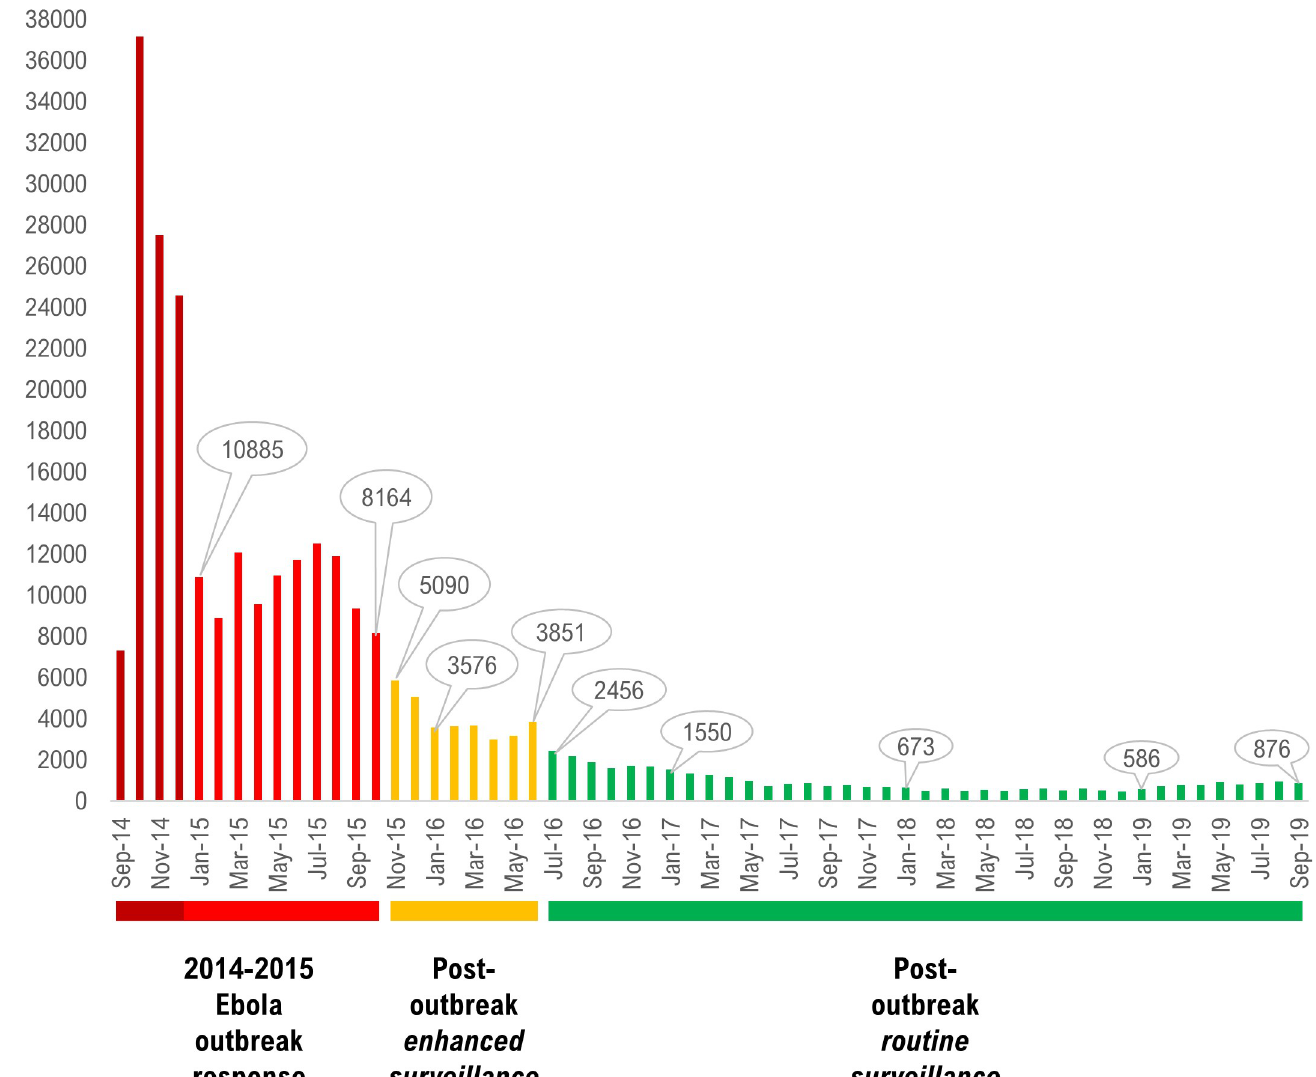
Fig 1. Distribution of the monthly unadjusted aggregated number of deaths reported to the 1-1-7 system, Sierra Leone, 2014–2019.